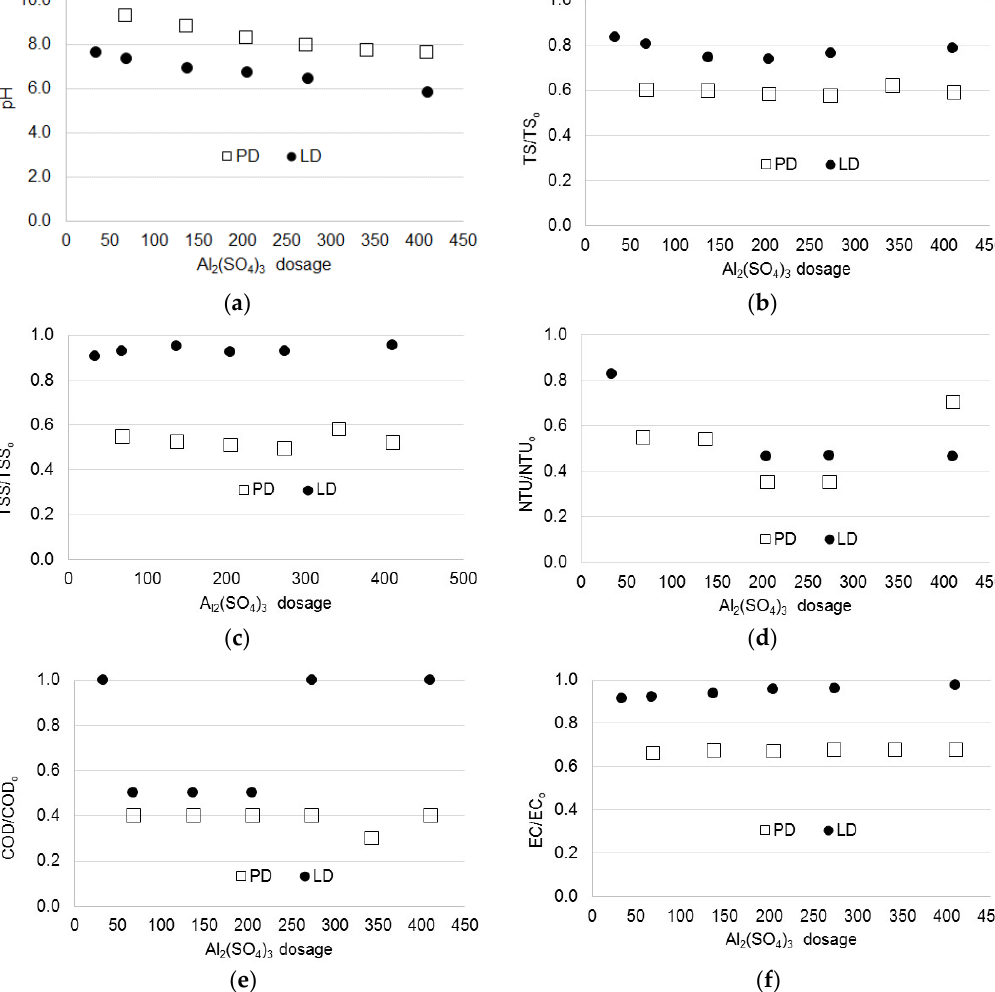
Figure 4. Optimum conditions for flocculation of powder detergent graywater. Figure 5. Optimum conditions for flocculation of liquid detergent graywater.